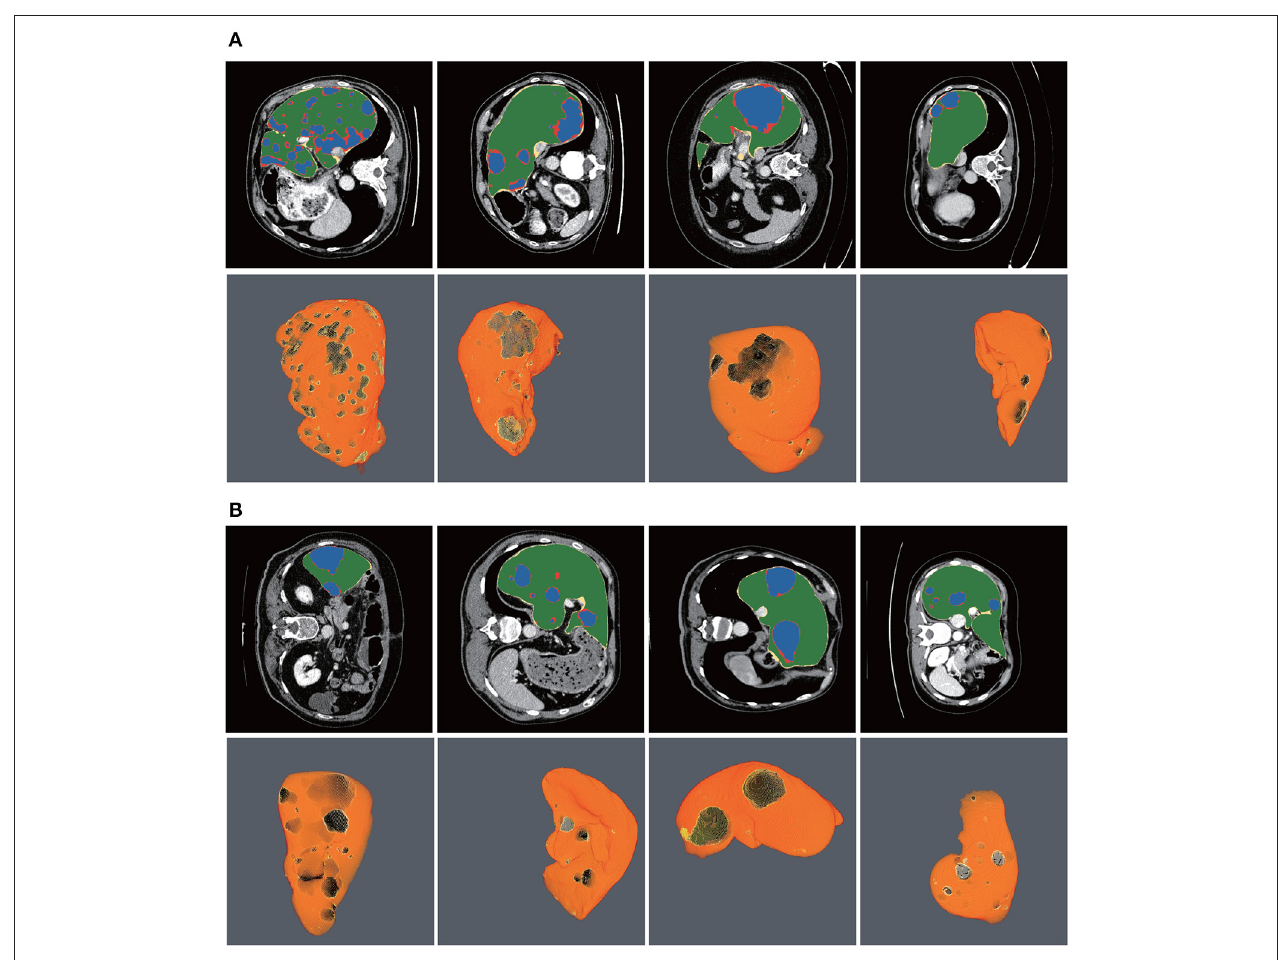
FIGURE 10 | Automatic liver and tumor segmentation with RA-UNet. The green regions indicate the correctly extracted liver, the yellow regions are the wrongly extracted liver, the blue color depicts the correctly extracted tumor regions, and the red color means wrongly extracted tumor. The first row of each subplot shows four slices from different volumes in the axial view and the second row of each subplot shows the corresponding 3D view of the entire liver/tumor segmentation results. (A) From the LiTS dataset. (B) From the 3DIRCADb dataset.